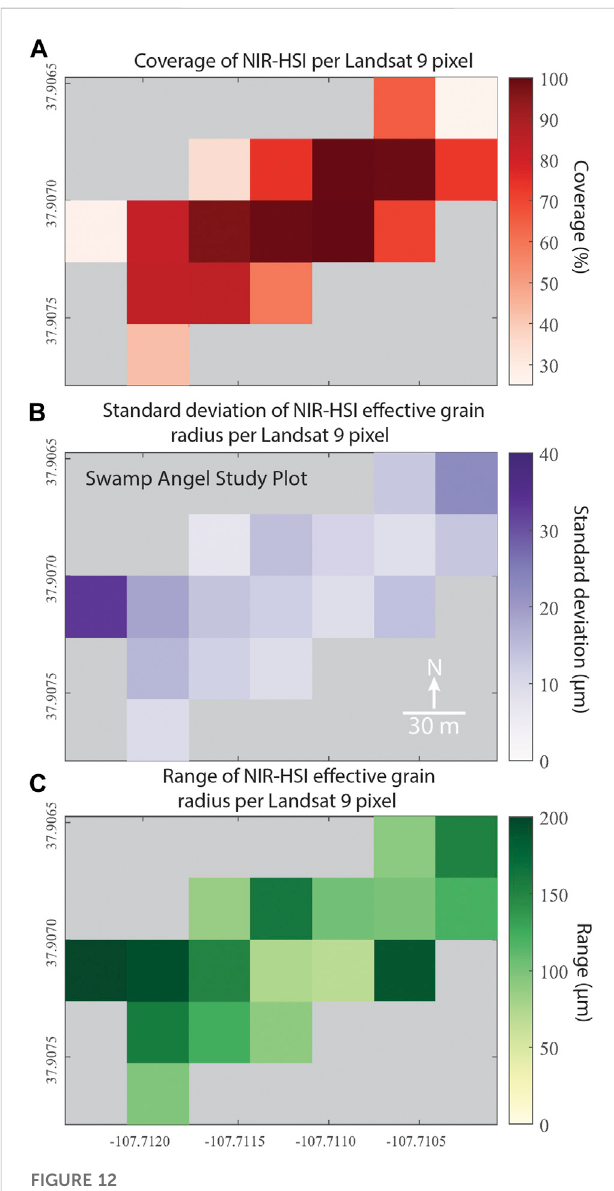
FIGURE 12 Landsat 9 NDGSI zonal statistics based on high resolution UAV-HSI effectivegrainsizeretrieval; (A) percentageofUAV-HSIpixelcoveragein each Landsat pixel, (B) standard deviation of effective grain size per Landsat 9 pixel based on UAV-HSI, and (C) the range of effective grain size per Landsat 9 pixel based on UAV-HSI.